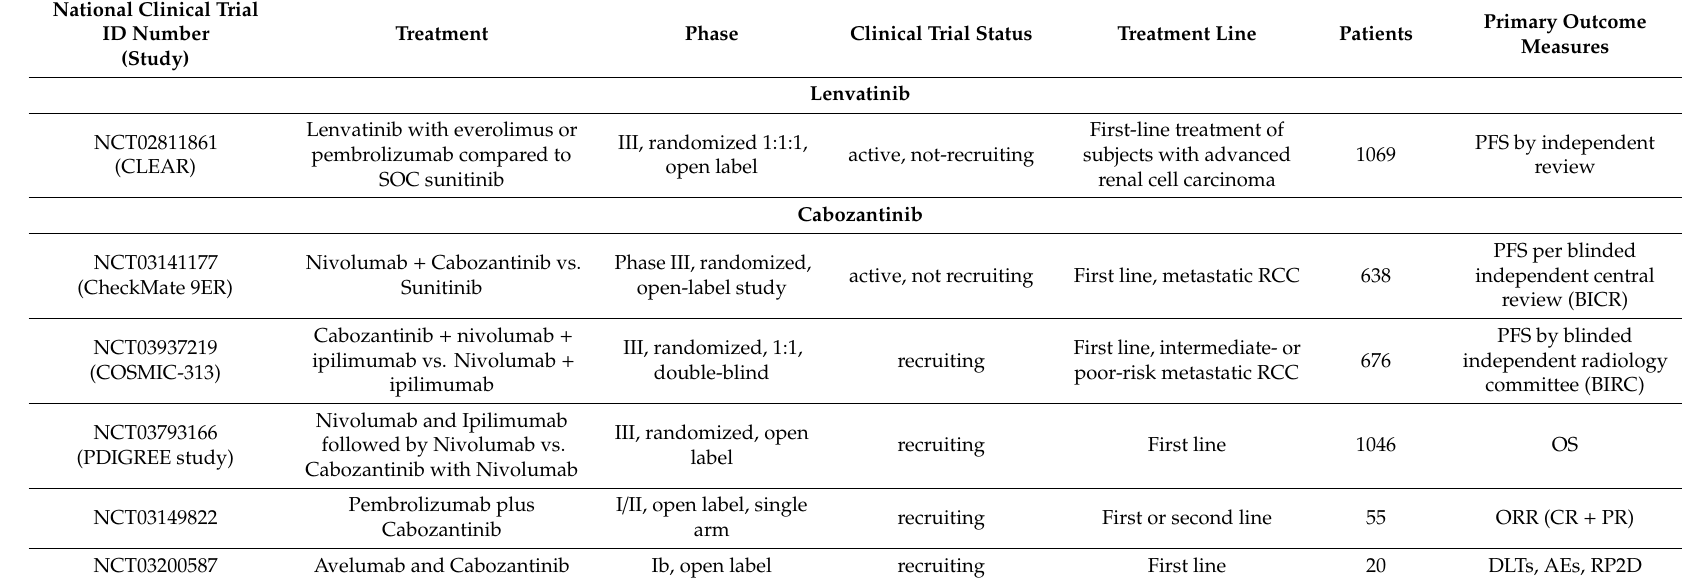
Table 2. Select ongoing VEGF / PD-1 blockade combination studies in